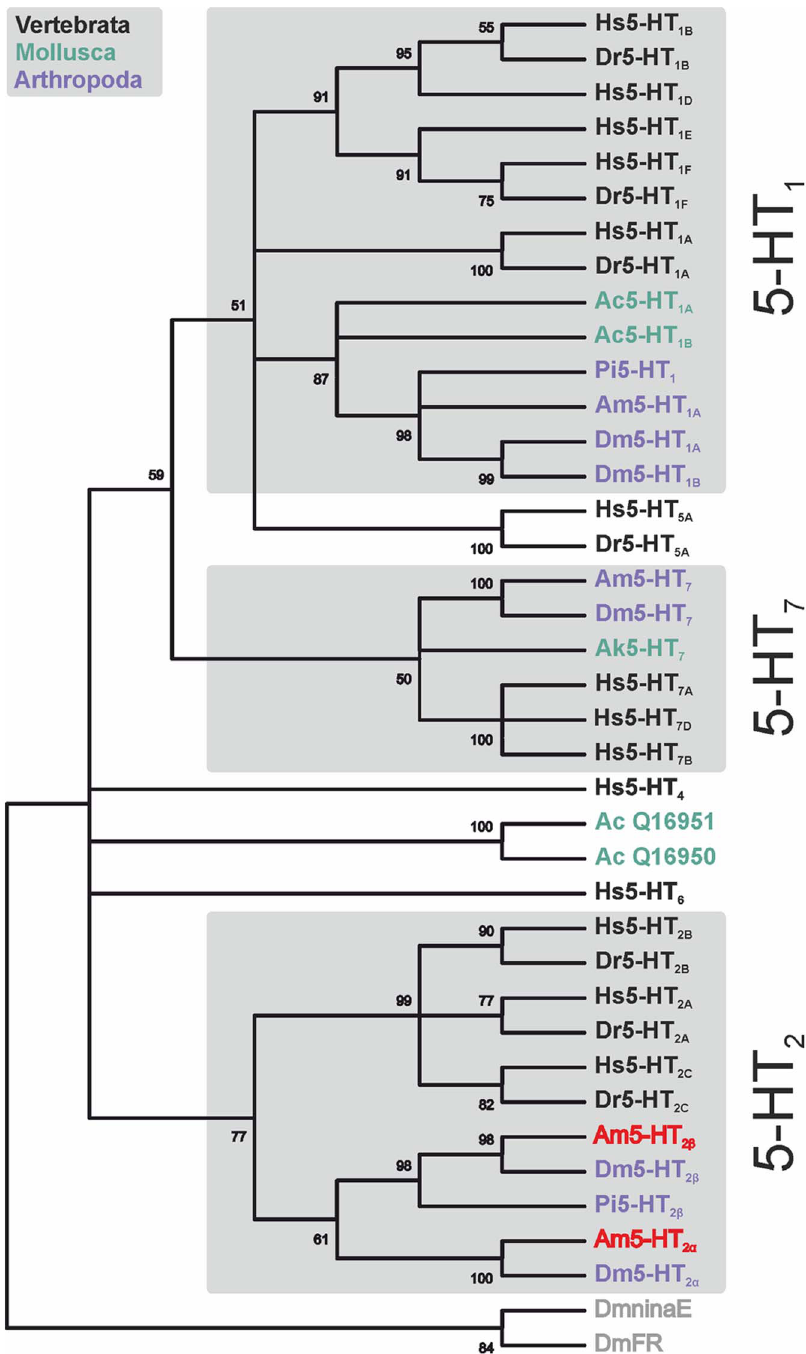
Figure 3. Phylogenetic relationship between various 5-HT receptors from vertebrates, mollusks, and arthropods. Alignments were performed with BioEdit (version 7.0.5) by using the core amino-acid sequences lacking the variable regions of the N- and C-terminus and the third cytoplasmic loop. Maximum parsimony analysis was calculated with MEGA4. The receptor sequences followed by their accession numbers are listed in the order illustrated: Homo sapiens (Hs5-HT 1B , acc. no. NP_000854), Danio rerio (Dr5-HT 1B , AAI63698), Hs5-HT 1D (NP_000855), Hs5-HT 1E (NP_000856), Hs5-HT 1F (NP_000857), Dr5-HT 1F (NP_001076425), Hs5-HT 1A (NP_000515), Dr5-HT 1A (NP_001139238), Aplysia californica (Ac5-HT 1 , AAM46088, AAC28786), Panulirus interruptus (Pi5-HT 1 , AY528822), Apis mellifera (Am5-HT 1 , CBI75449), Drosophila melanogaster (Dm5-HT 1A , CAA77570), Dm5-HT 1B (CAA77571), Hs5-HT 5A (NP_076917), Dr5-HT 5A , (NP_001119882), Am5-HT 7 (AM076717), Dm5-HT 7 (NP_524599), Aplysia kurodai (Ak5-HT 7 , ACQ90247), Hs5-HT 7A (NP_000863), Hs5-HT 7D (NP_062873), Hs5-HT 7B (NP_062874), Hs5-HT 4 (NP_001035259), Ac5-HT 2 (Q16951), Ac5-HT 1 (Q16950), Hs5-HT 6 (NP_000862), Hs5-HT 2B (NP_000858), Dr5-HT 2B (ABI18978), Hs5-HT 2A (NP_000612), Dr5-HT 2A (CAQ15355), Hs5-HT 2C (NP_000859), Dr5-HT 2C (CAX14715), Am5-HT 2 b (FR727108), Dm5-HT 2 b (NM_141548/NM_169229), Pi5-HT 2 b (AY550910), Am5-HT 2 a (FR727107), and Dm5-HT 2 a (CAA57429). The divergent D. melanogaster ninaE-encoded rhodopsin 1 (DmninaE, NM_079683) and D. melanogaster FMRFamide receptor (DmFR, AAF47700) were used as out-groups. The numbers at the nodes of the branches represent the percentage bootstrap support (2,000 replications) for each branch. doi:10.1371/journal.pone.0082407.g003 PLOS ONE |